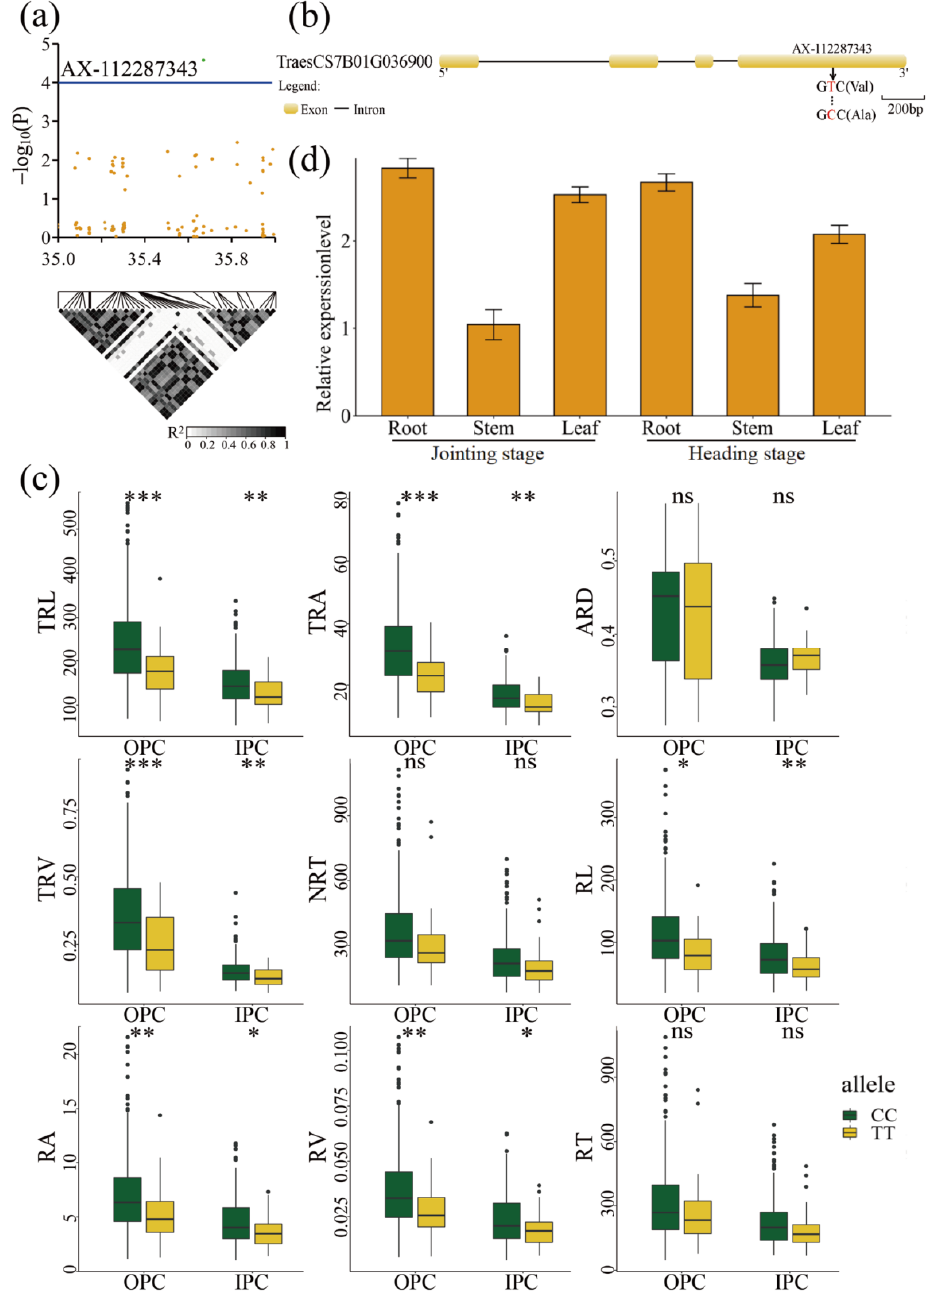
Figure 6. GWAS results of the nine RSA traits and identification of the candidate gene for the SNP AX-112287343 on chromosome 7B. ( a ) Manhattan plot for the candidate region on chromosome 7B. The green dot represents the significant SNP AX-112287343. The LD block analysis of the SNPs in this region is shown below. The degree of linkage is represented by the coefficient of r 2 . ( b ) Gene structure of TraesCS7B01G036900 and its non-synonymous SNP. Yellow rectangles and black lines represent exons and introns, respectively. The arrow indicates the position of amino acid variations in TraesCS7B01G036900. ( c ) Box plots for RSA traits based on the allele at SNP AX-112287343. Differences between the haplotypes were statistically analysed using the Student’s t -test. The upper and lower edges of the box represent the 75th and 25th quantiles, respectively, and the whiskers show the 90th and 10th quantiles; the horizontal solid line represents the average; * Significant at p ≤ 0.05, ** Significant at p ≤ 0.01, *** Significant at p ≤ 0.001. ( d ) Expression profile of TraesCS7B01G036900 in different tissues, as determined by RT-qPCR. The data are the means ± Sd of n = 3. ‘ns’ means ‘not